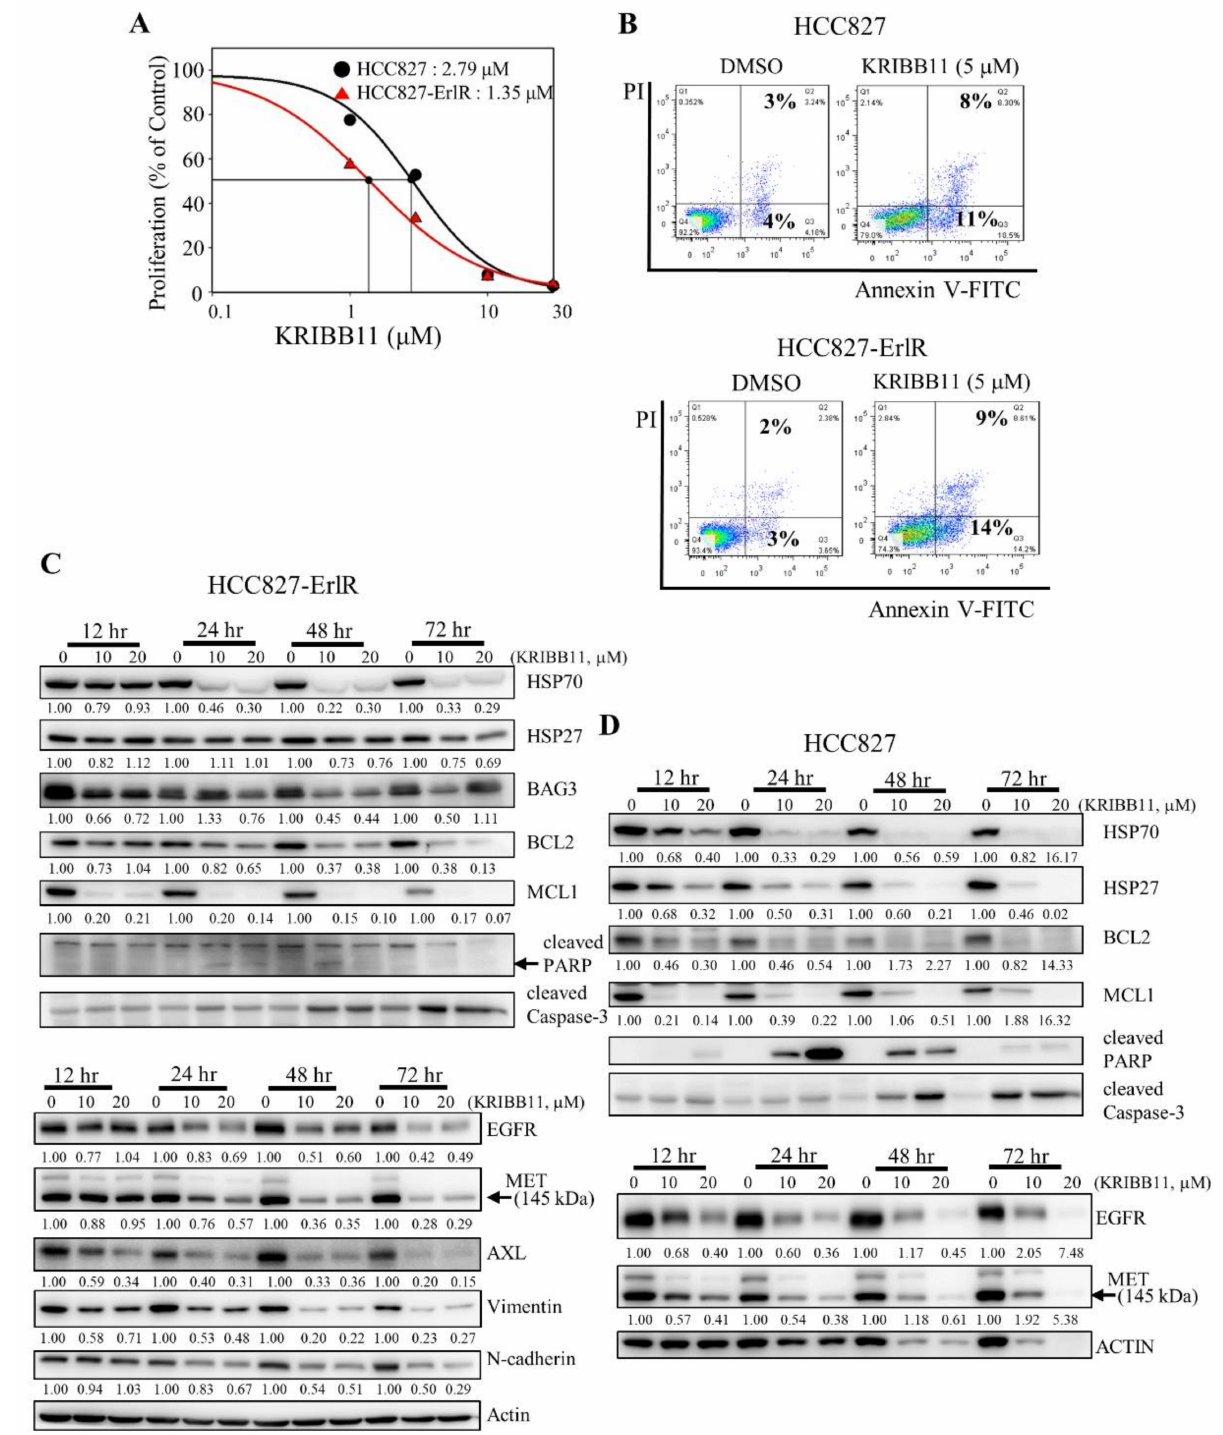
Figure 4. The HSF1 inhibitor KRIBB11 inhibits the proliferation of HCC827 and HCC827-ErlR cells and induces apoptosis. ( A ) HCC827 and HCC827-ErlR cells were treated with 0.1% DMSO or different concentrations of KRIBB11. After incubation for 72 h, cells were counted using a microscope. Proliferation is expressed as the percentage of KRIBB11-treated cells compared with 0.1% DMSO-treated cells. Each value is the mean ± S.D. ( B ) HCC827 and HCC827-ErlR cells treated for 48 h with 0.1% DMSO or 5 µ M KRIBB11 were analyzed by annexin-V/FITC/PI flow cytometry. ( C , D ) HCC827-ErlR ( C ) and HCC827 ( D ) cells were treated with 0.1% DMSO or KRIBB11 (10, 20 µ M) for 12–72 h, and whole cell lysates were analyzed by Western blotting with antibodies as indicated (the protein band intensity was normalized to the actin band